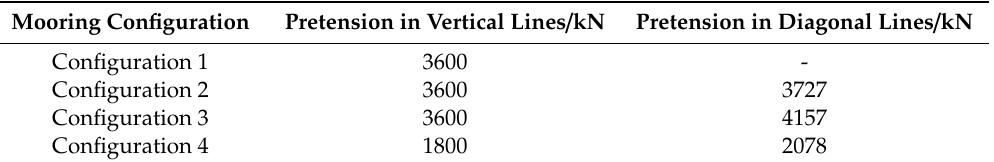
Table 6. Pretension in mooring